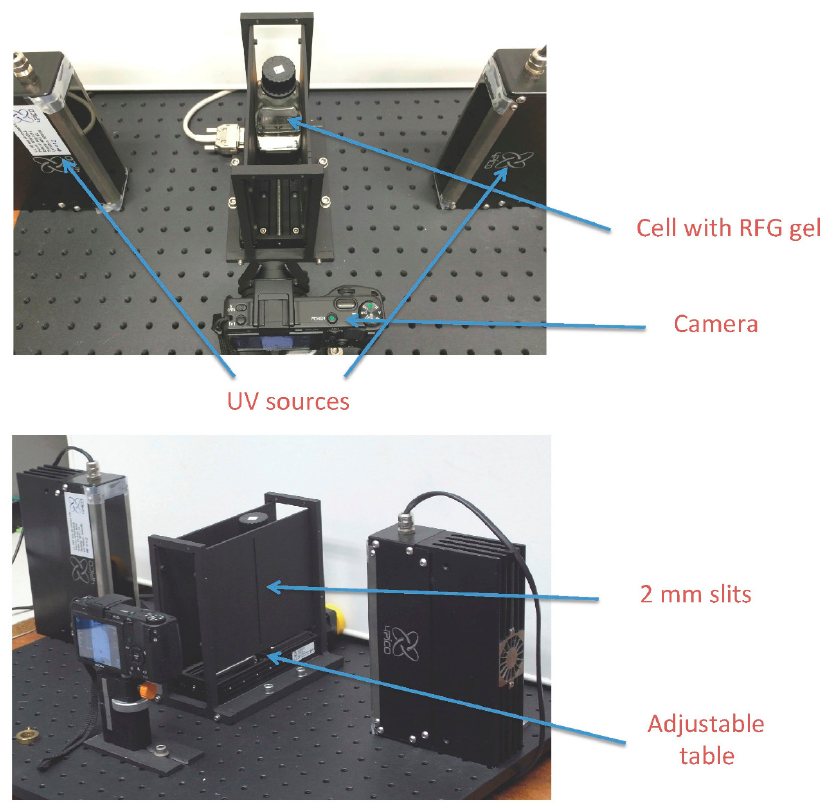
Figure 1. The bench-top prototype to FluoroTome 1.